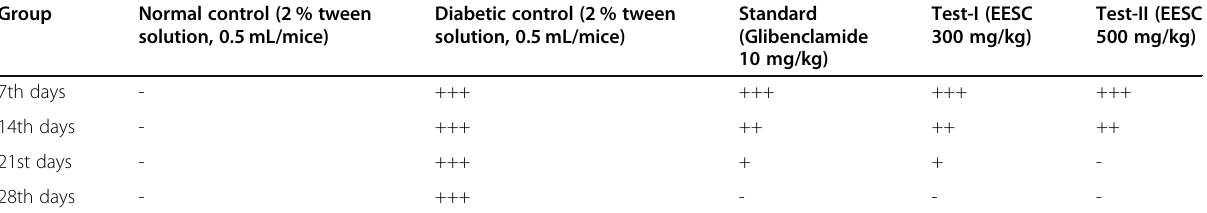
Table 11 Effect of S. caseolaris fruits extracts on urine glucose (mg/dL) in STZ-induced diabetic mice Group Normal control (2 % tween solution, 0.5